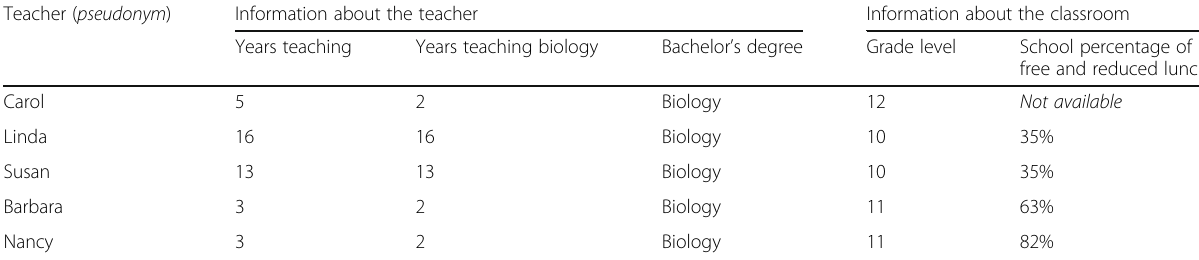
Table 1 Information about the participants of the